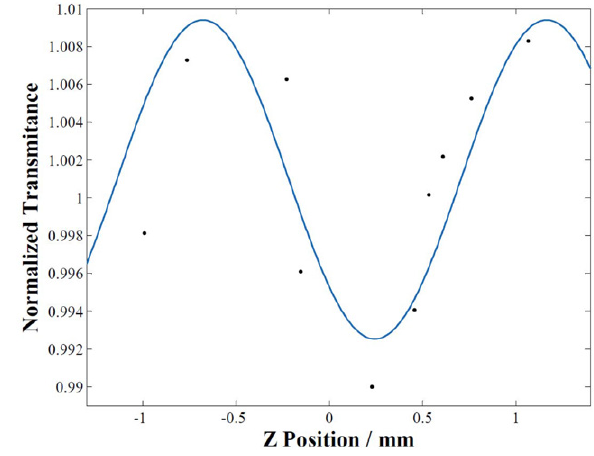
Figure 5. Closed aperture Z-Scan data for 4-(4,5-Diphenyl- 1H-im- idazole-2-yl) phenol